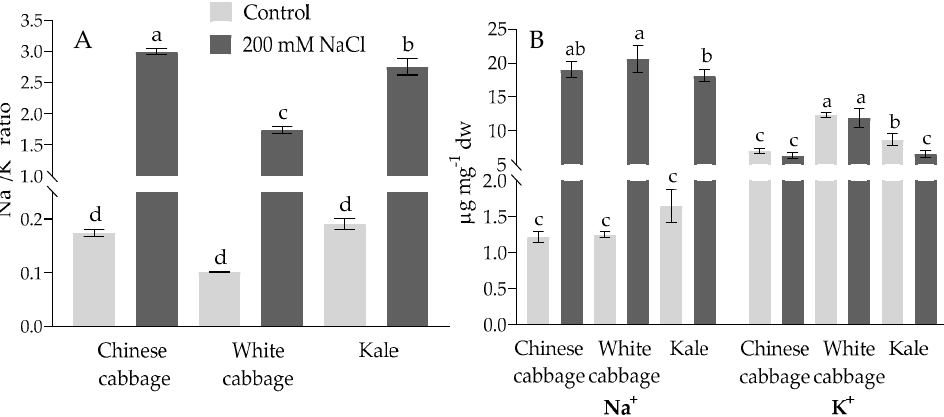
Figure 2. Brassica seedlings’ NA + /K + ratio ( A ), and Na + and K + content ( B ) under control and salt stress (200 mM NaCl) treatments. Data are averages ± SD ( n = 4). Points labelled with different letters differ significantly at p < 0.05.